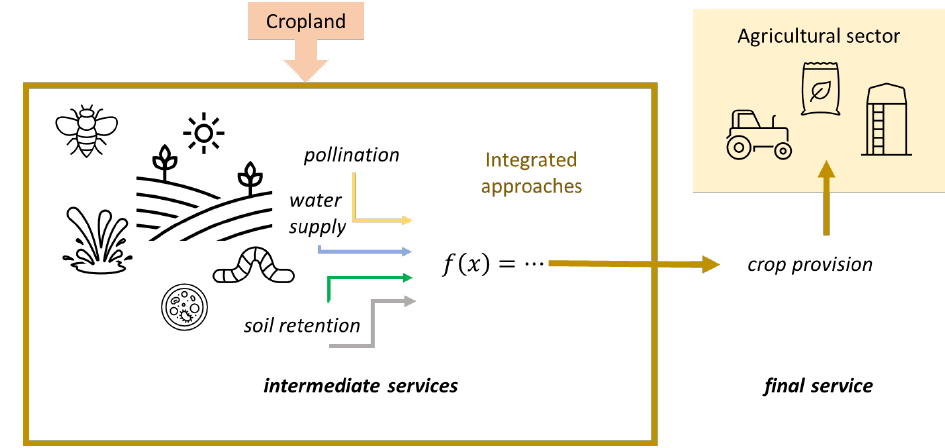
Figure 3. Crop provision assessment based on a comprehensive approach.